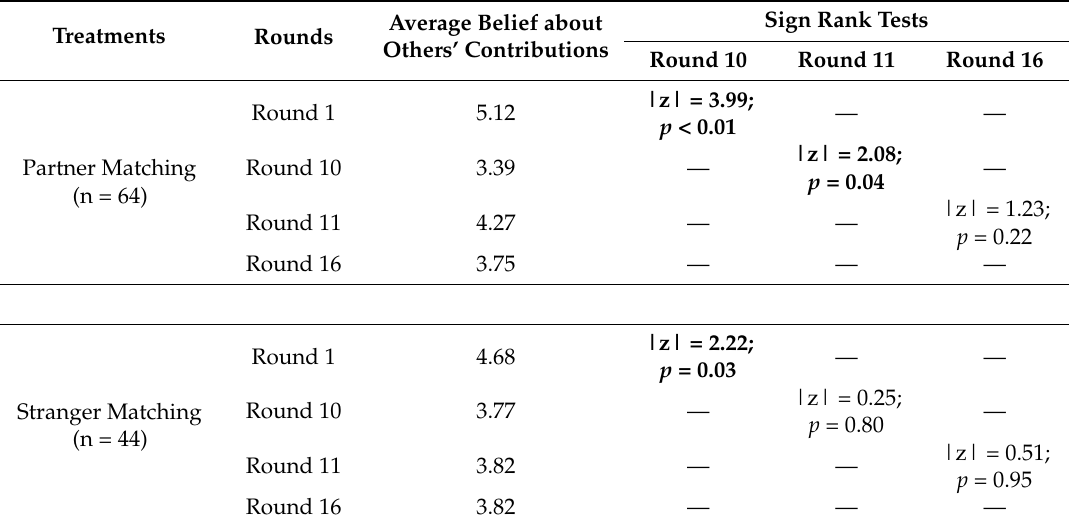
Table 4. Nonparametric sign rank tests comparing beliefs in Rounds 1, 10, 11, and